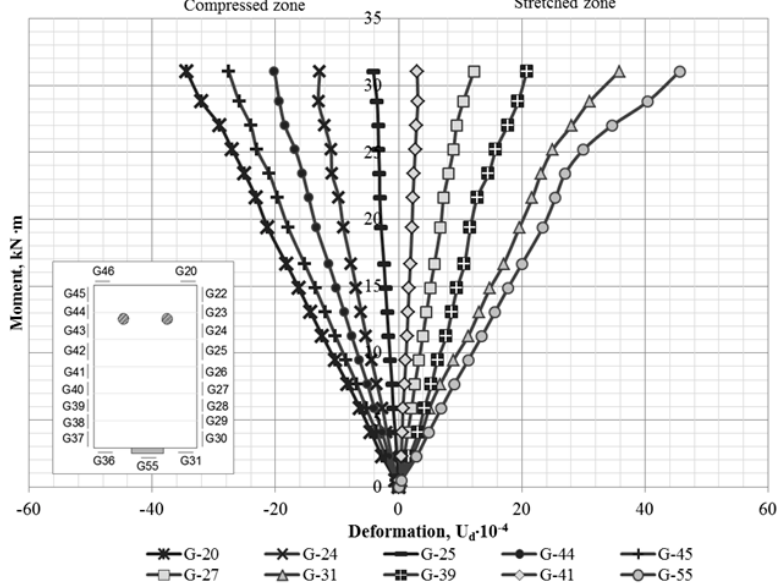
Figure 5. Graphical chart of layer deformation of sample cross-section fibers of GRB-12B beam in span middle.